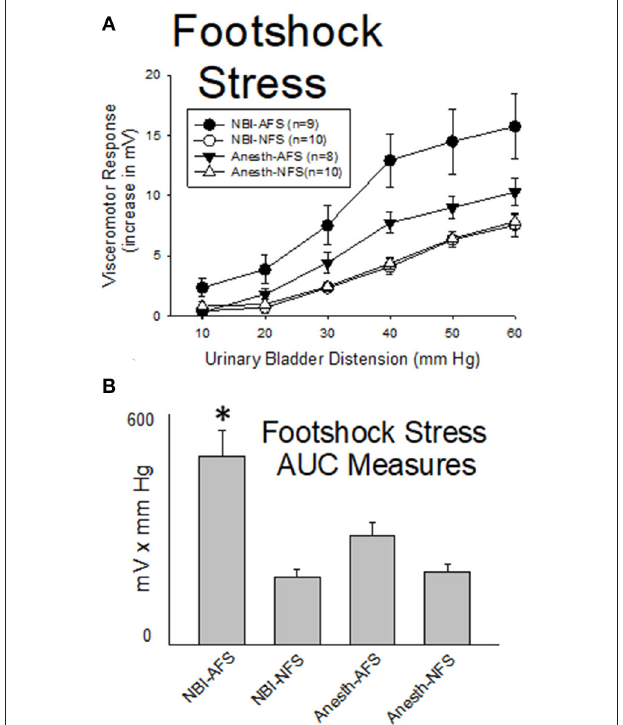
FIGURE 6 | Footshock Stress Augments VMRs in Rats Which Experienced NBI. Presentation is similar to that of Figures 2 – 4 (group stimulus-response functions in (A) ; Area-Under-the-Curve, AUC, measures in (B) ). Rats which had experienced NBI demonstrated statistically greater VMRs to UBD compared with controls when presented with acute footshock stress (AFS) as a second insult as adults. *indicates VMRs in the NBI-AFS group was statistically more robust than all other groups ( p < 0.05). See text for greater explanation and